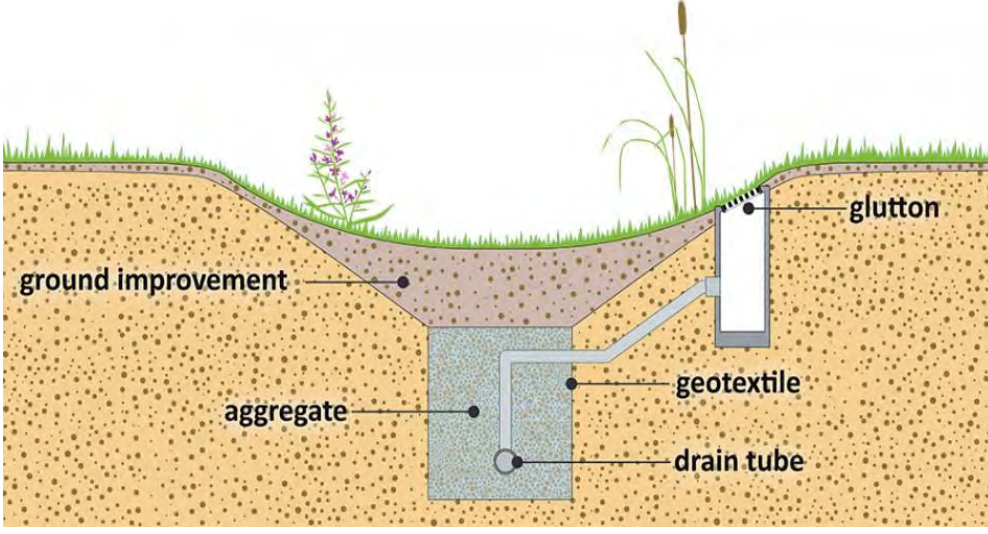
Fig.9: Section scheme of a bioswale when it is dry. (Boogaard et al, 2006)